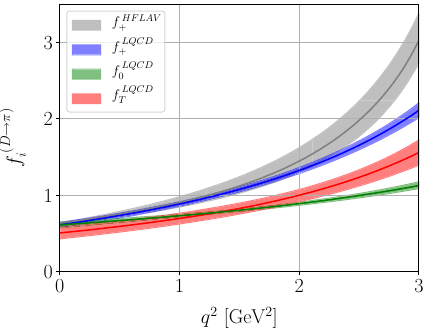
Fig. 11 The D → π formfactors f + , f 0 , f T fromlatticeQCD[11,12] and f + from HFLAV [40] (gray band) with 1 σ theoretical